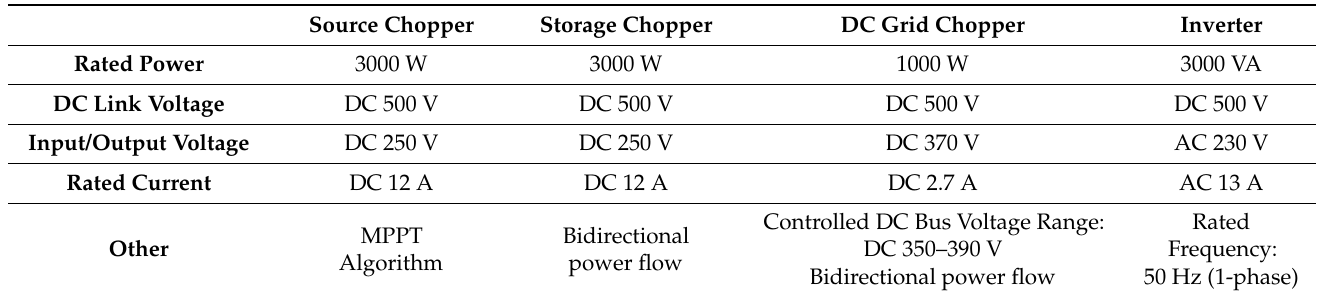
Table 1. Specifications of each converter in a PCS unit.